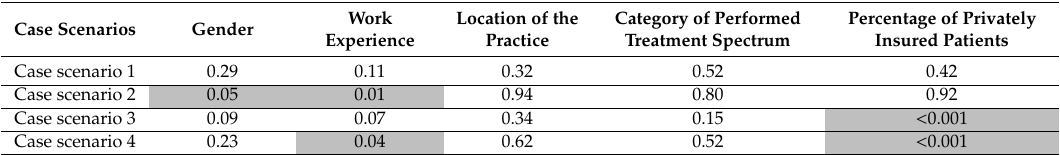
Table 7. p -value of statistical association analysis by Chi-squared tests between the first-ranked treatment option of the four di ff erent case scenarios and di ff erent